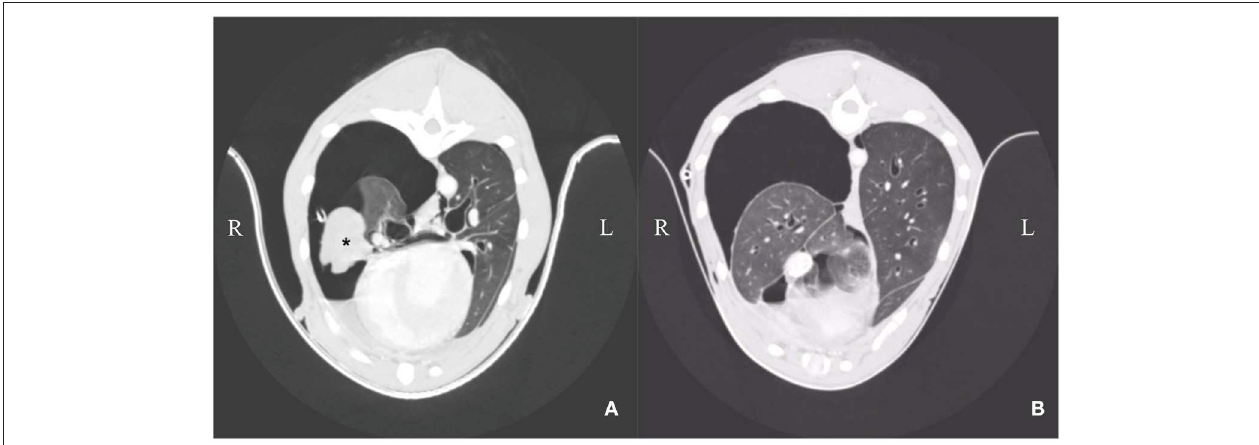
FIGURE 2 | (A,B) Day 3: Computer tomography: Heterogenous pleural thickening of multiple lung lobes is seen. The right middle lung lobe is severely atrophic and atelectatic (asterisk). The remaining lung lobes are expanded to ∼ 40% on the right side. Left lung lobes are nearly completely re-expanded on the left side. Mild pleural effusion is present (right >